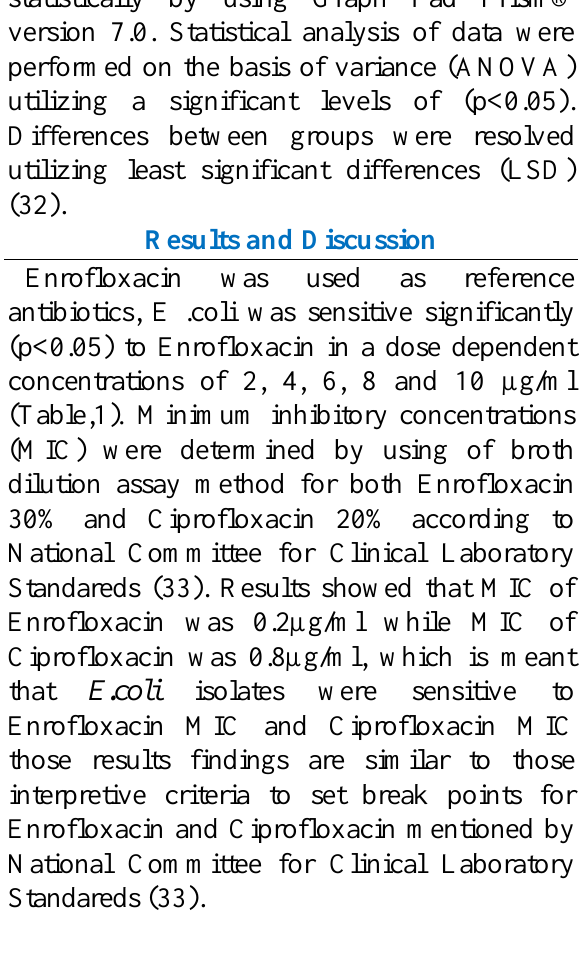
Table, 1: Antibacterial activity of Enrofloxacin against E.coli. Con.(µg/ml) Zone of inhibition (mm)